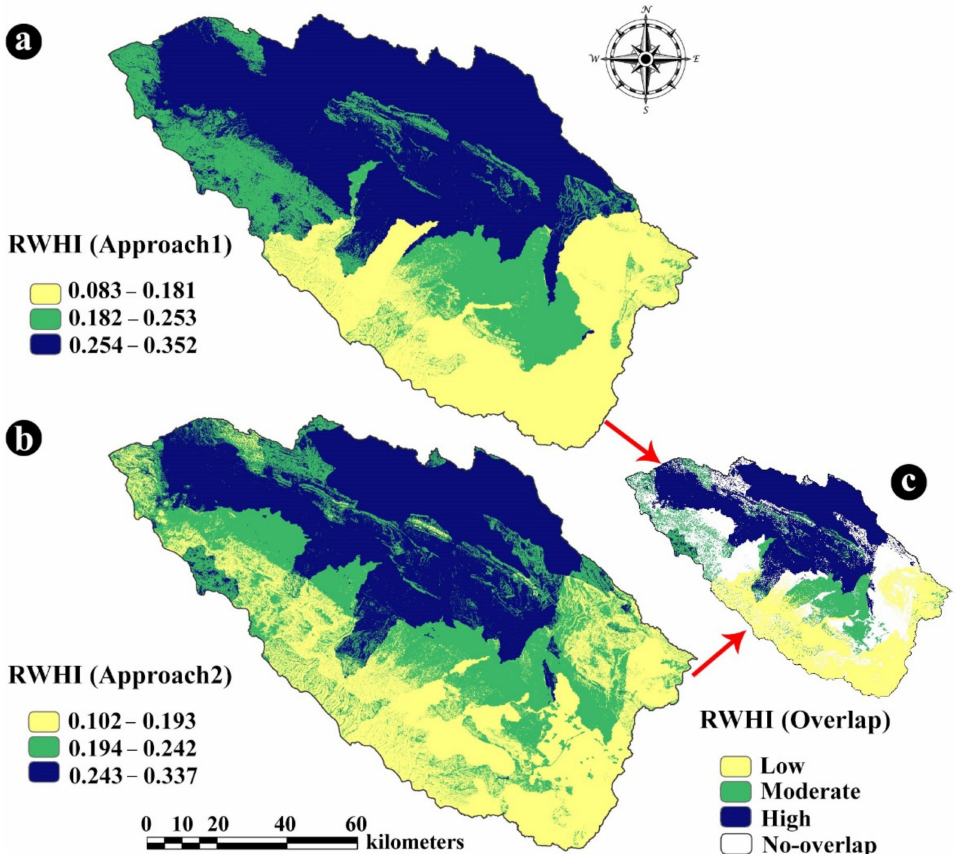
Figure 4. RWH potential map of the study area for the first and second approaches and for the overlap of the two approaches.